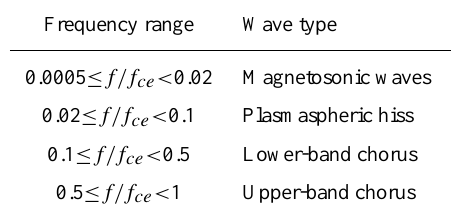
Table 1. Frequency ranges used in the